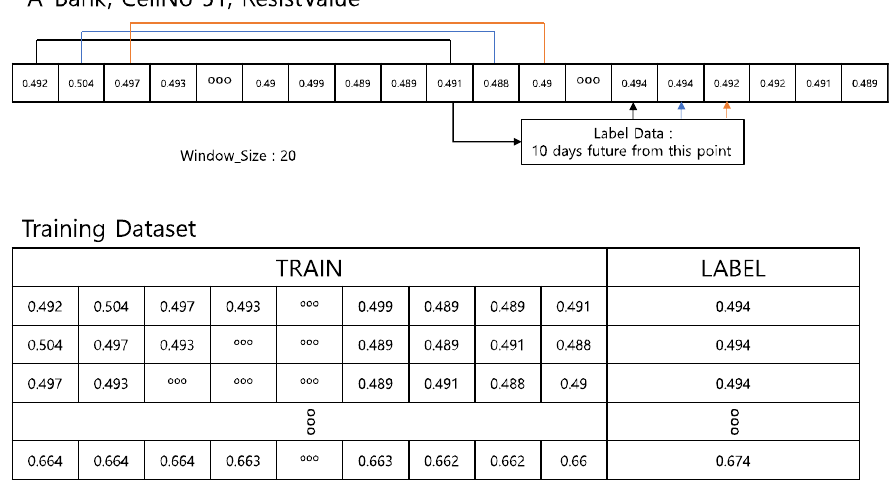
Figure 8. RNN block.